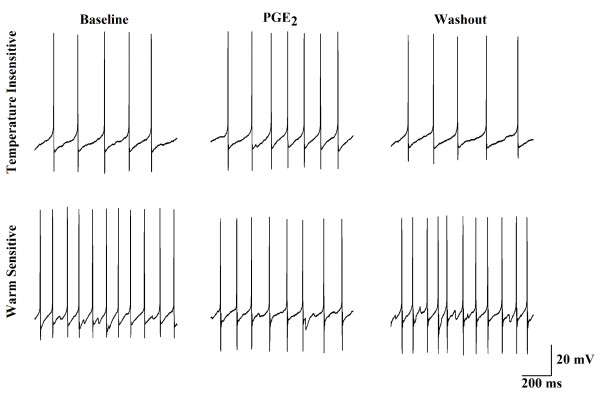
The effects of temperature and PGE2 on the activity of a VMPO temperature insensitive neuron and a VMPO warm sensitive neuron. The top panels show one second records of the action potential activity of a VMPO temperature insensitive neuron during all three experimental conditions (resting membrane potential = -43.94 mV). The firing rate significantly increased from a baseline of 5.11 ± 0.12 impulses·s-1 to 7.33 ± 0.13 impulses·s-1 during perfusion with 1 μM PGE2 (washout = 4.90 ± 0.14 impulses·s-1). The lower panels show one second records of the action potential activity of a VMPO warm sensitive neuron during all three experimental conditions (resting membrane potential = -51.62 mV). The firing rate significantly decreased from a baseline of 10.07 ± 0.13 impulses·s-1 to 8.40 ± 0.12 impulses·s-1 during perfusion with 1 μM PGE2 (washout = 10.20 ± 0.16 impulses·s-1).